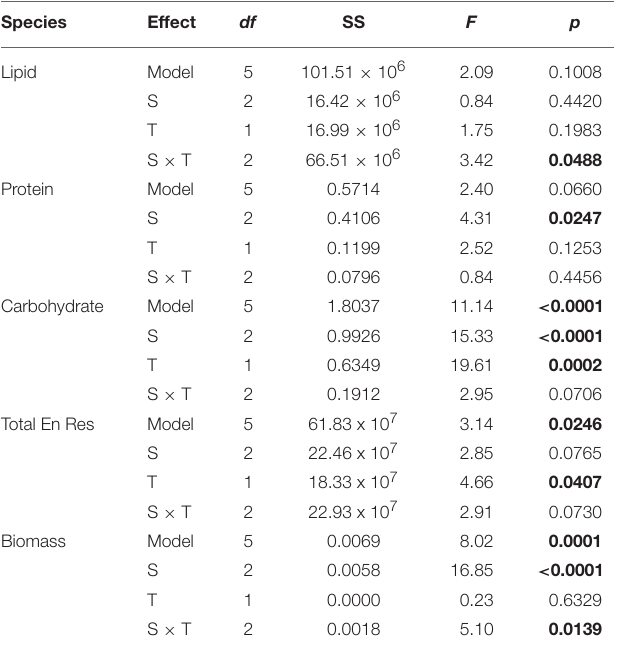
TABLE 2 | Results of five two-way ANOVAs testing for the effect of species (S), and temperature (T) on average lipid, protein, carbohydrate, total energy reserves, and total biomass.